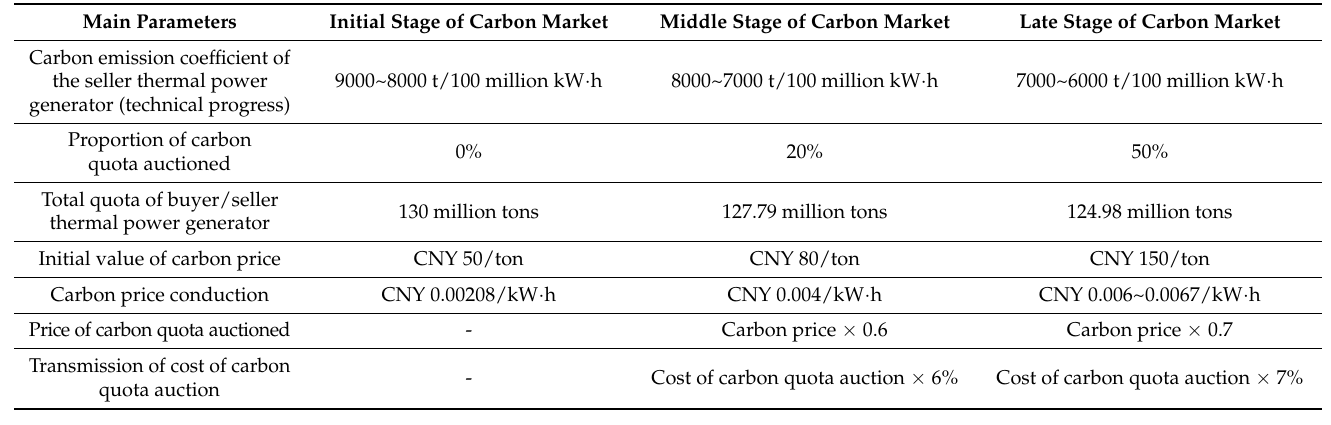
Table 2. Multi-scenario settings.